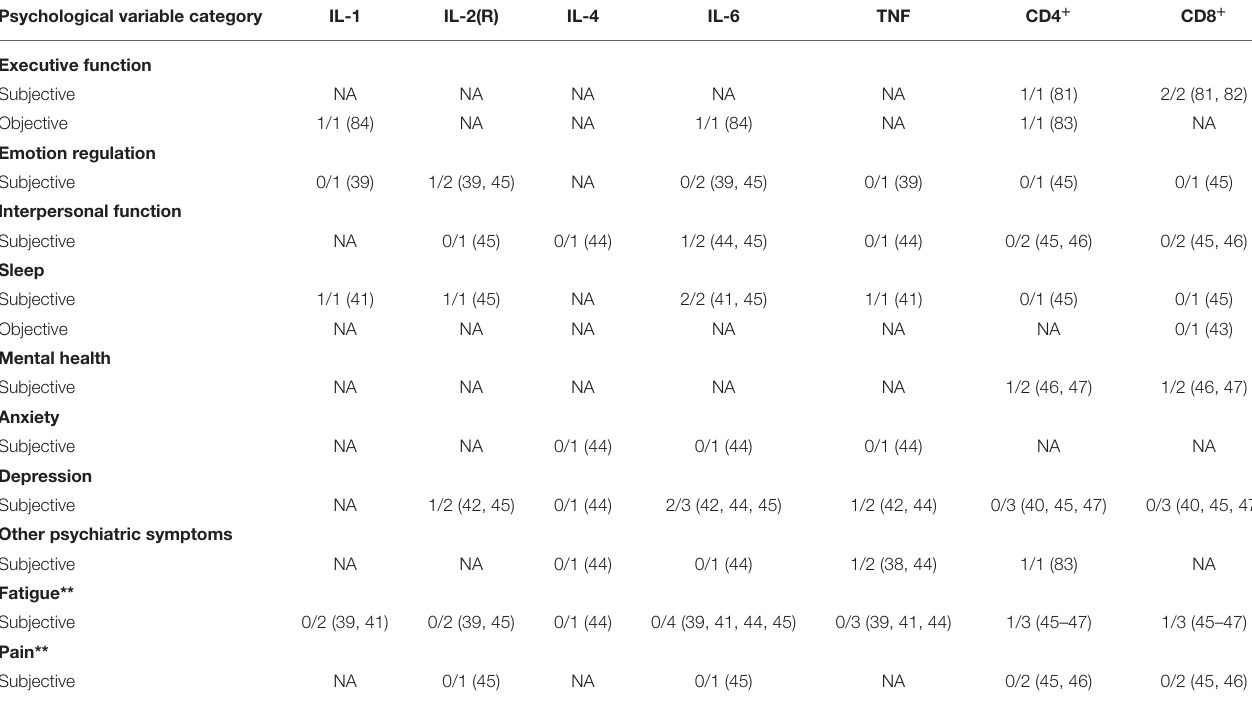
TABLE 4 | An overview of the current evidence base on cross-sectional associations between psychological and immunological variables in CFS/ME. Psychological variable